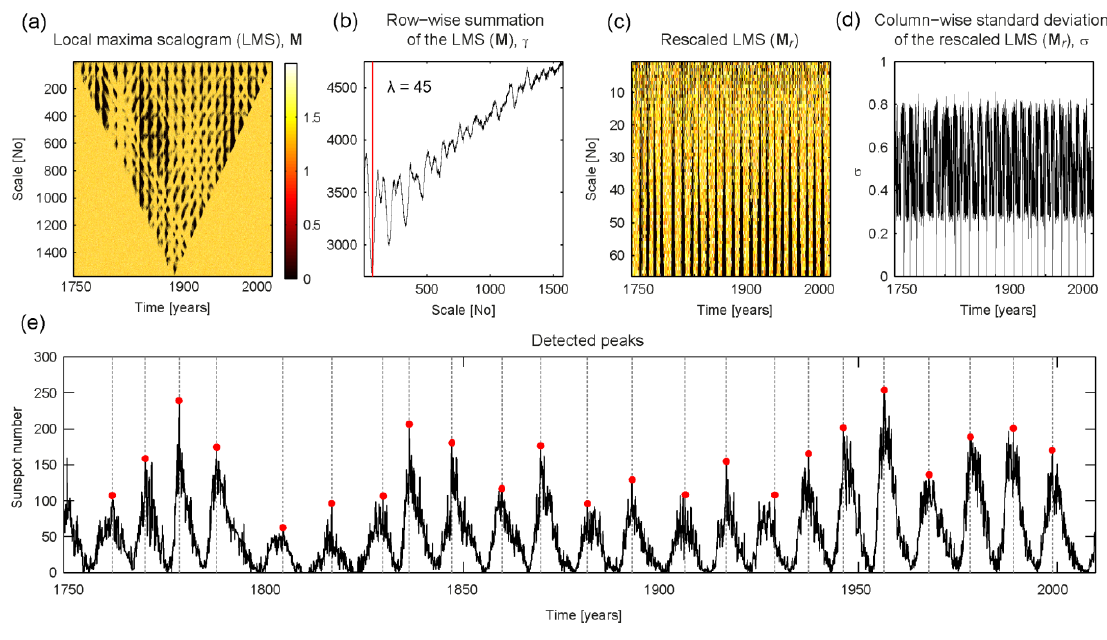
Figure 5. Results of applying the AMPD algorithm to a time series comprising the monthly total number of